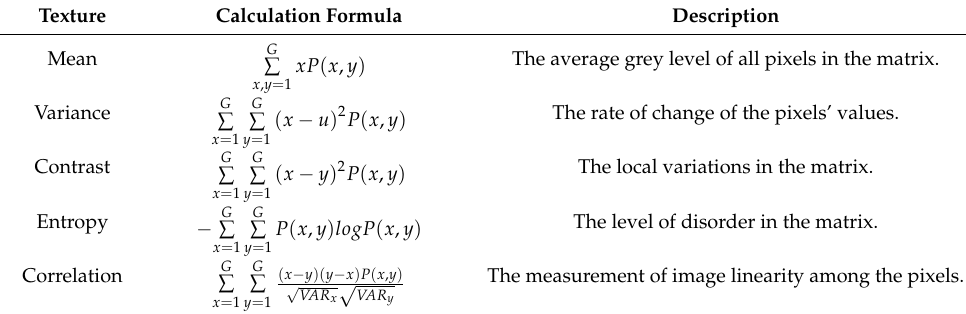
Table 3. Texture Features (TFs) were used for the identification of abandoned jujube fields in this